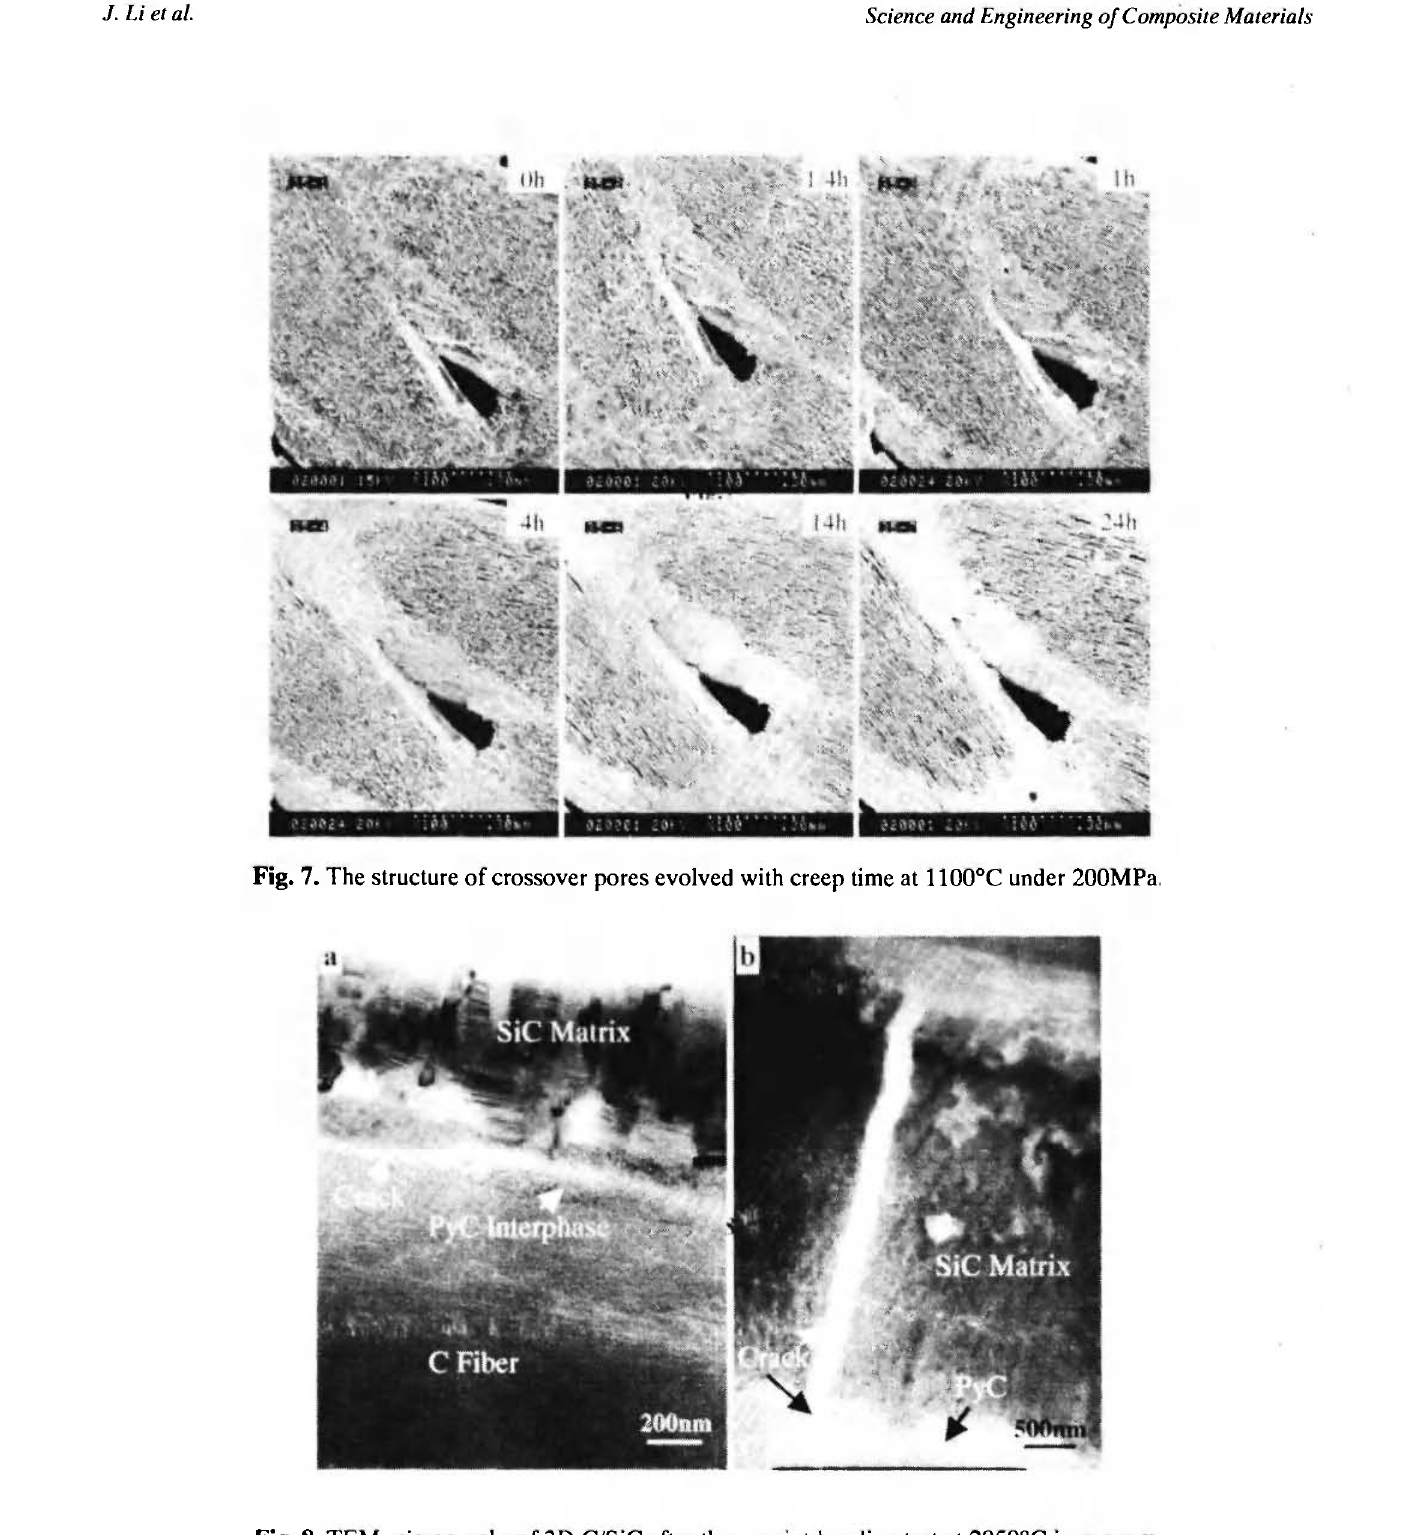
Fig. 8. TEM micrographs of 3D C/SiC after three-point-hending test at 2050°C in vacuum.